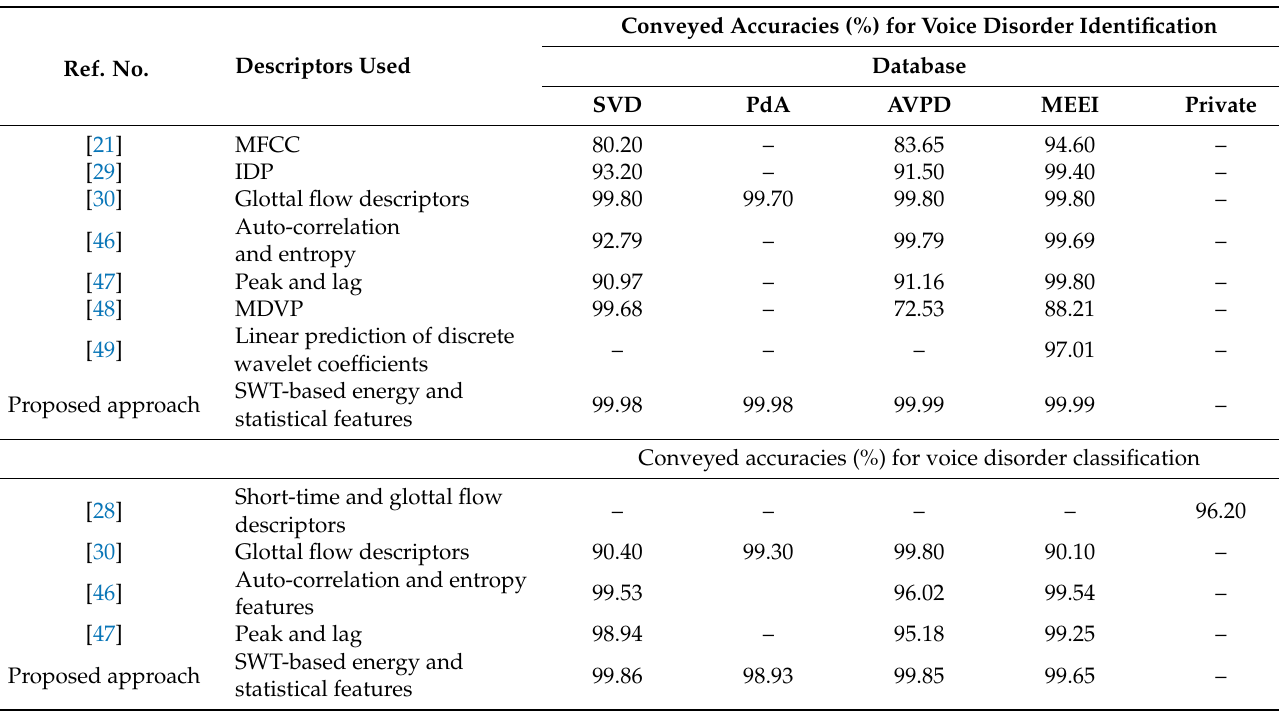
Table 17. Comparison with existing